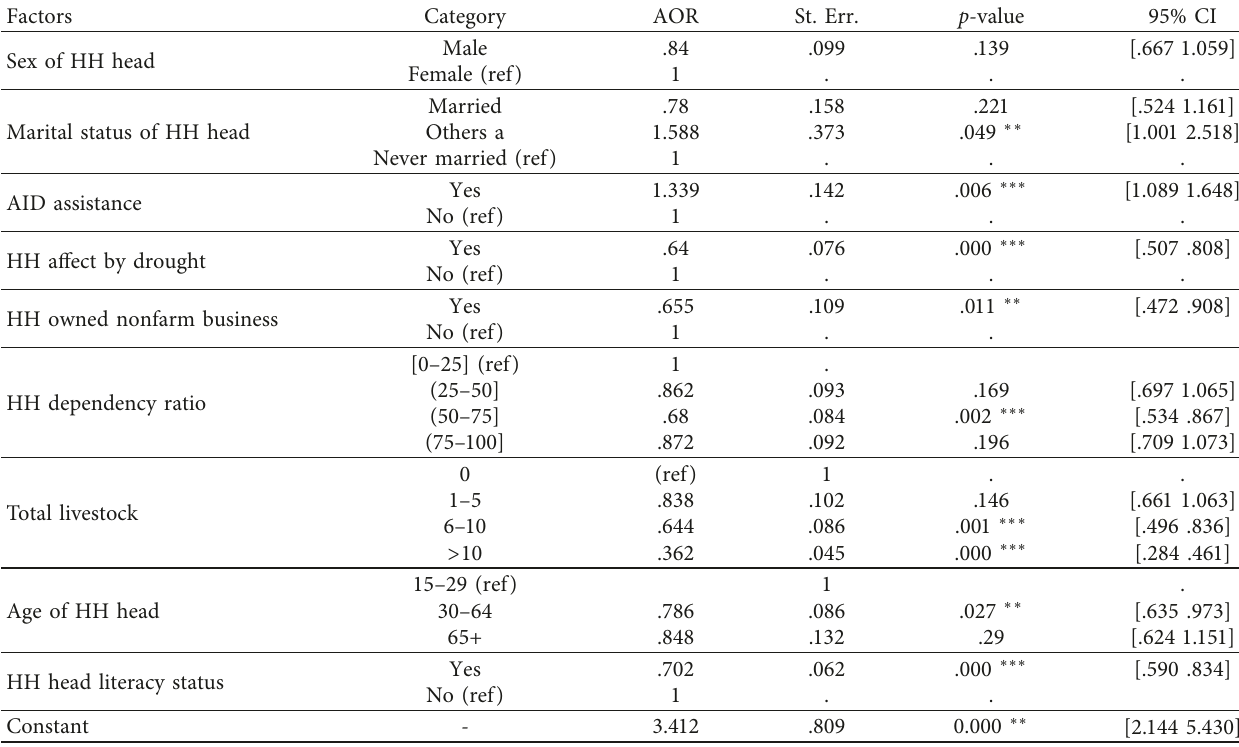
Table 5: Estimates of binary logistic regression and determinants of household’s food security in rural Ethiopia.